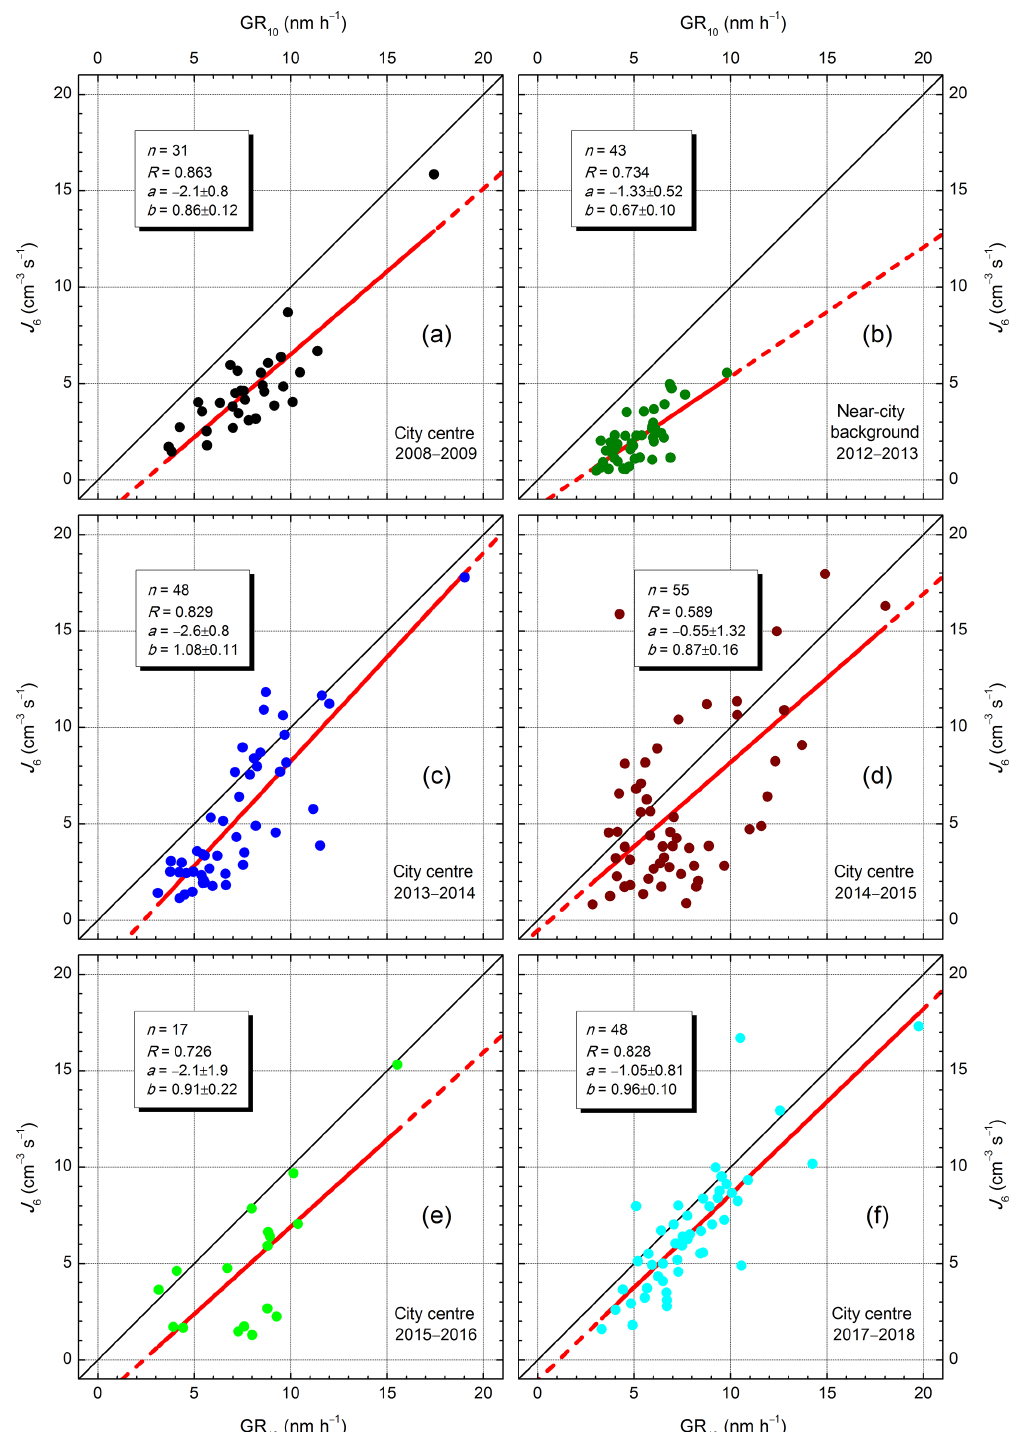
Figure 4. Scatter plots for aerosol particle formation rate J 6 and particle diameter growth rate GR 10 in city centre ( a , c–f ) and near-city background (b) separately for the 1-year-long measurement time intervals. Number of data points ( n ), their coefficient of correlation ( R ) and the intercept ( a ) and slope ( b ) of the regression line with standard deviations are also indicated. The lines in black represent the line with a slope of 1, and the solid lines in red show the regression lines, while the dashed parts in red are extrapolated from the regression